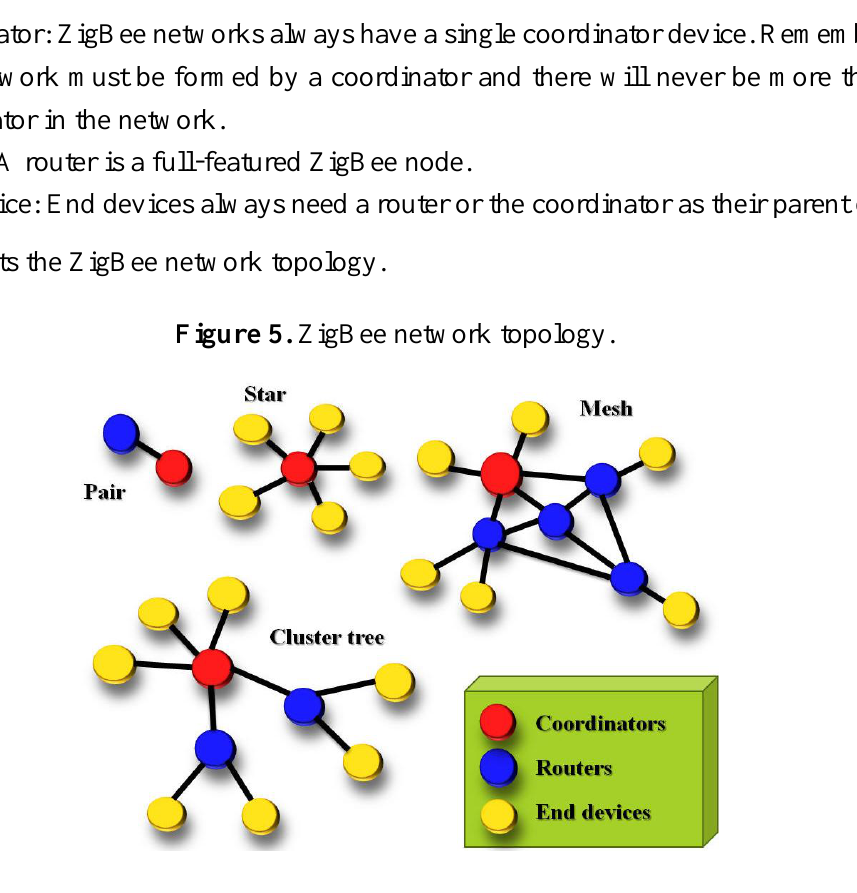
Figure 6. These ZigBee modules are employed to build our monitoring